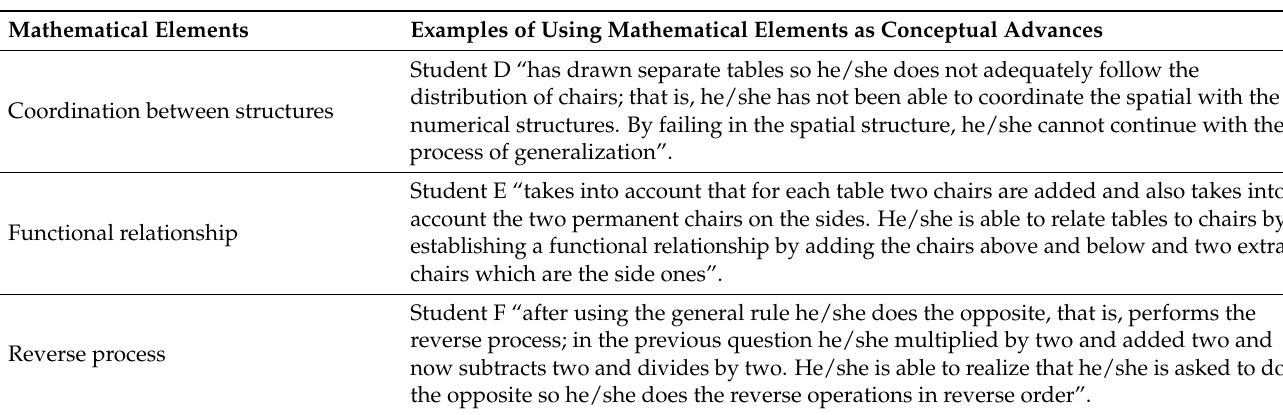
Table 3. Examples of evidence of understanding mathematical elements as conceptual advances.